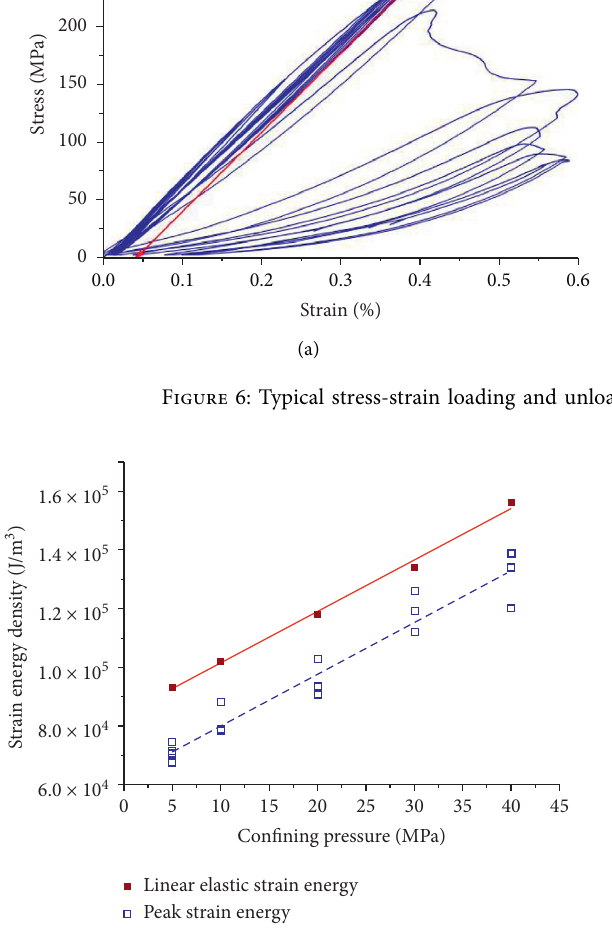
Figure 7: Strain energy density values of the peak unloading and crack initiation point